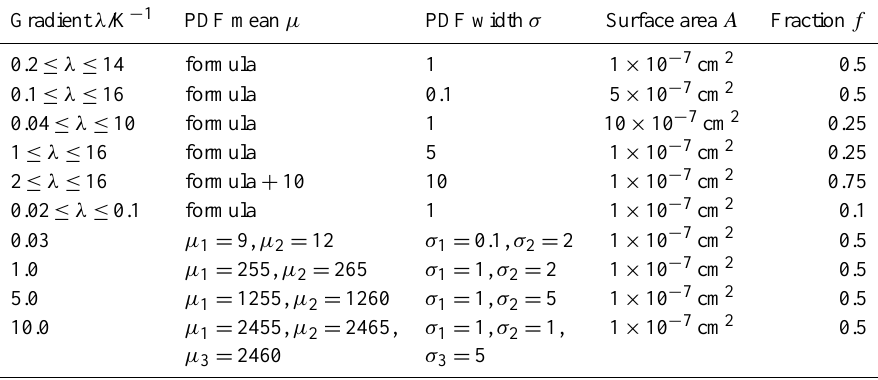
Table 1. The range of MCSM variables used for droplet cooling simulations in Fig. 3: λ is − dln( J s ,i ) /d T ; µ and σ are the mean and standard deviation of the PDF used to constrain the occurrence of each component with “formula” referring to µ = 240 λ + 14.8; surface area of immersed INP per droplet A ; and the fraction f at which the change in temperature ( 1T = (f r calculated. All simulations were performed at cooling rates of 1 and 10Kmin − 1